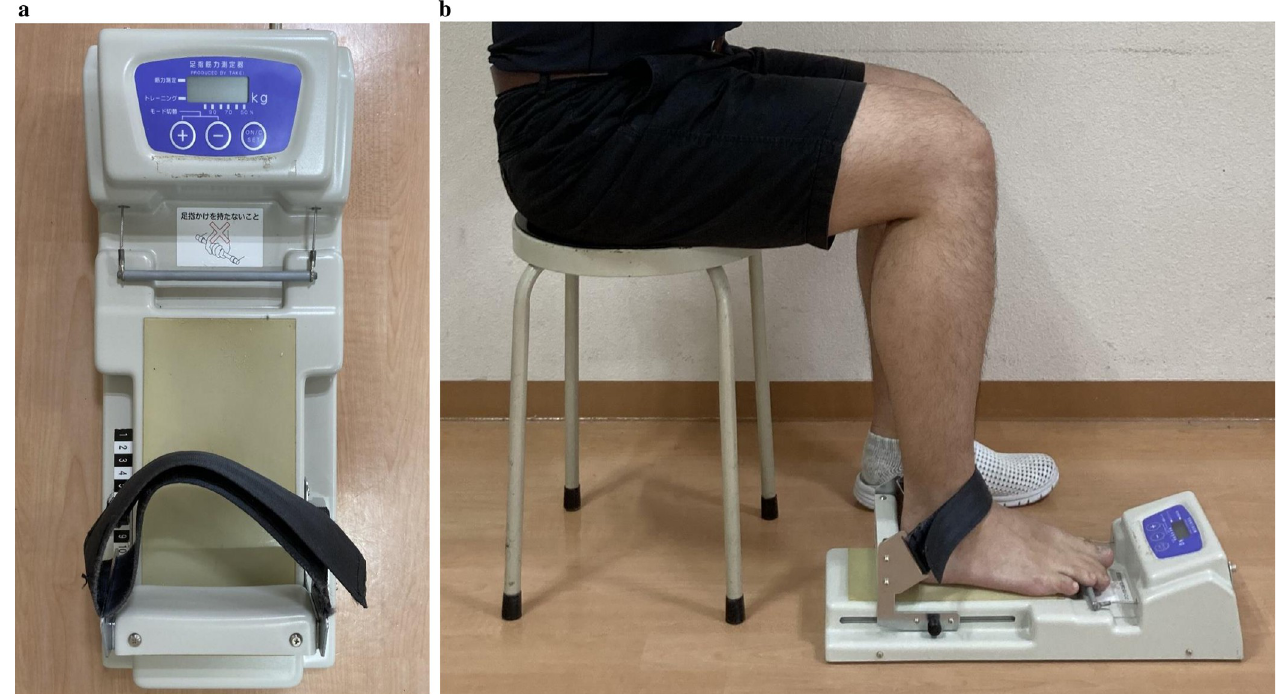
Fig 1. Toe grip strength assessment. a. Toe grip dynamometer employed to measure toe grip strength. b. The grip bar of the instrument was adjusted to the first metatarsophalangeal joint of the participant. The participants sat on the edge of their seats keeping their trunks in a vertical position and the hip and knee joints bent to approximately